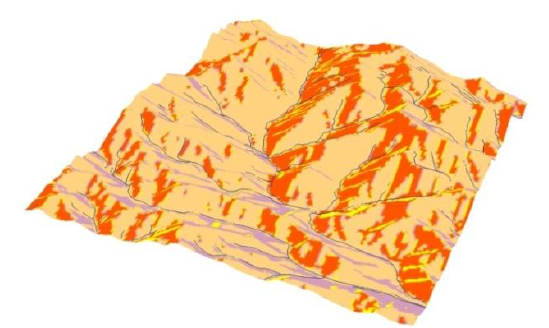
Figure 2. Exposure of Trans-Ili Alatau slopes